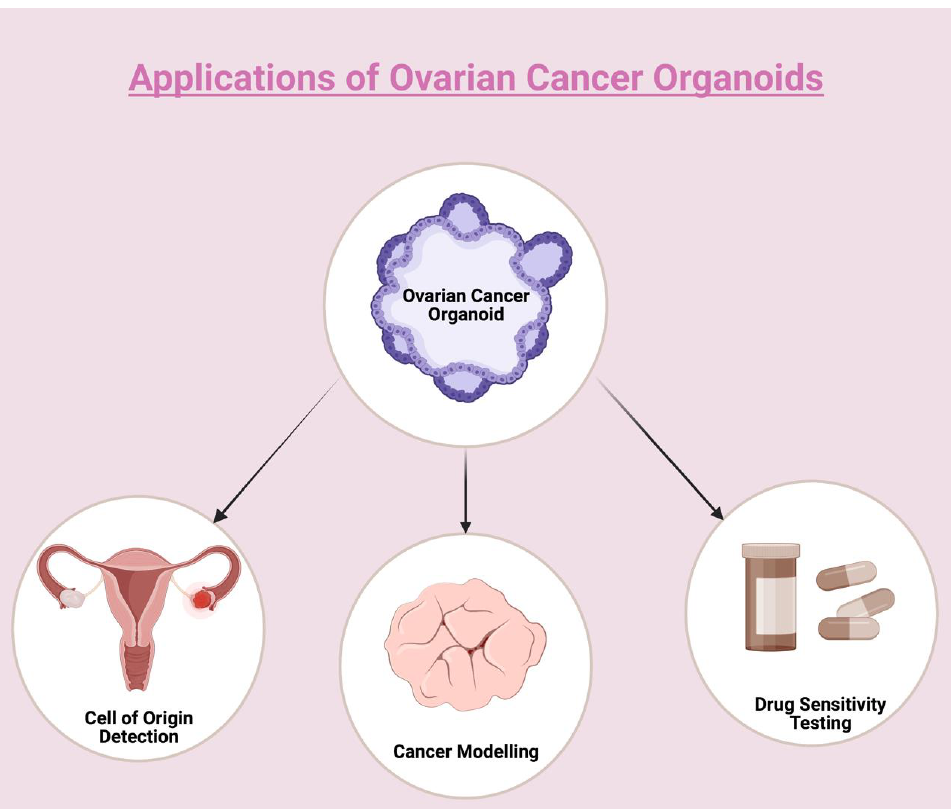
Figure 1. The use of OC organoids for HGSOC cell of origin detection, disease modeling and drug sensitivity testing. Created with BioRender.com.